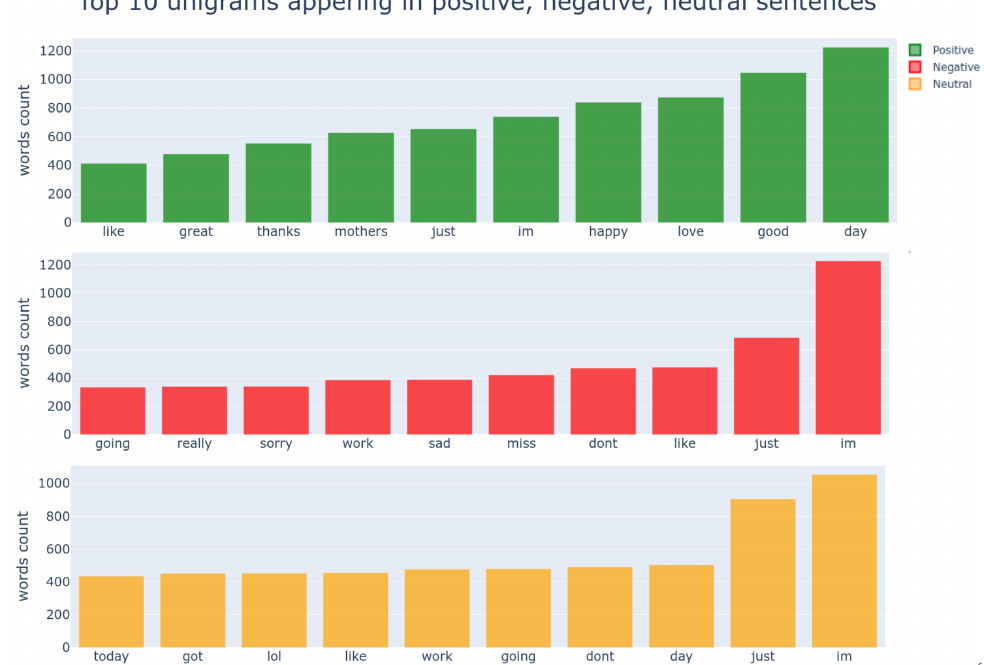
Figure 9. Statistic of top 10 unigrams in positive, negative, neutral sentiment. “im;’ and “just;’ appear in all sentiments with high counts, implying that leveraging unigrams meta information may cause confusion for models and lead to inferior performances.